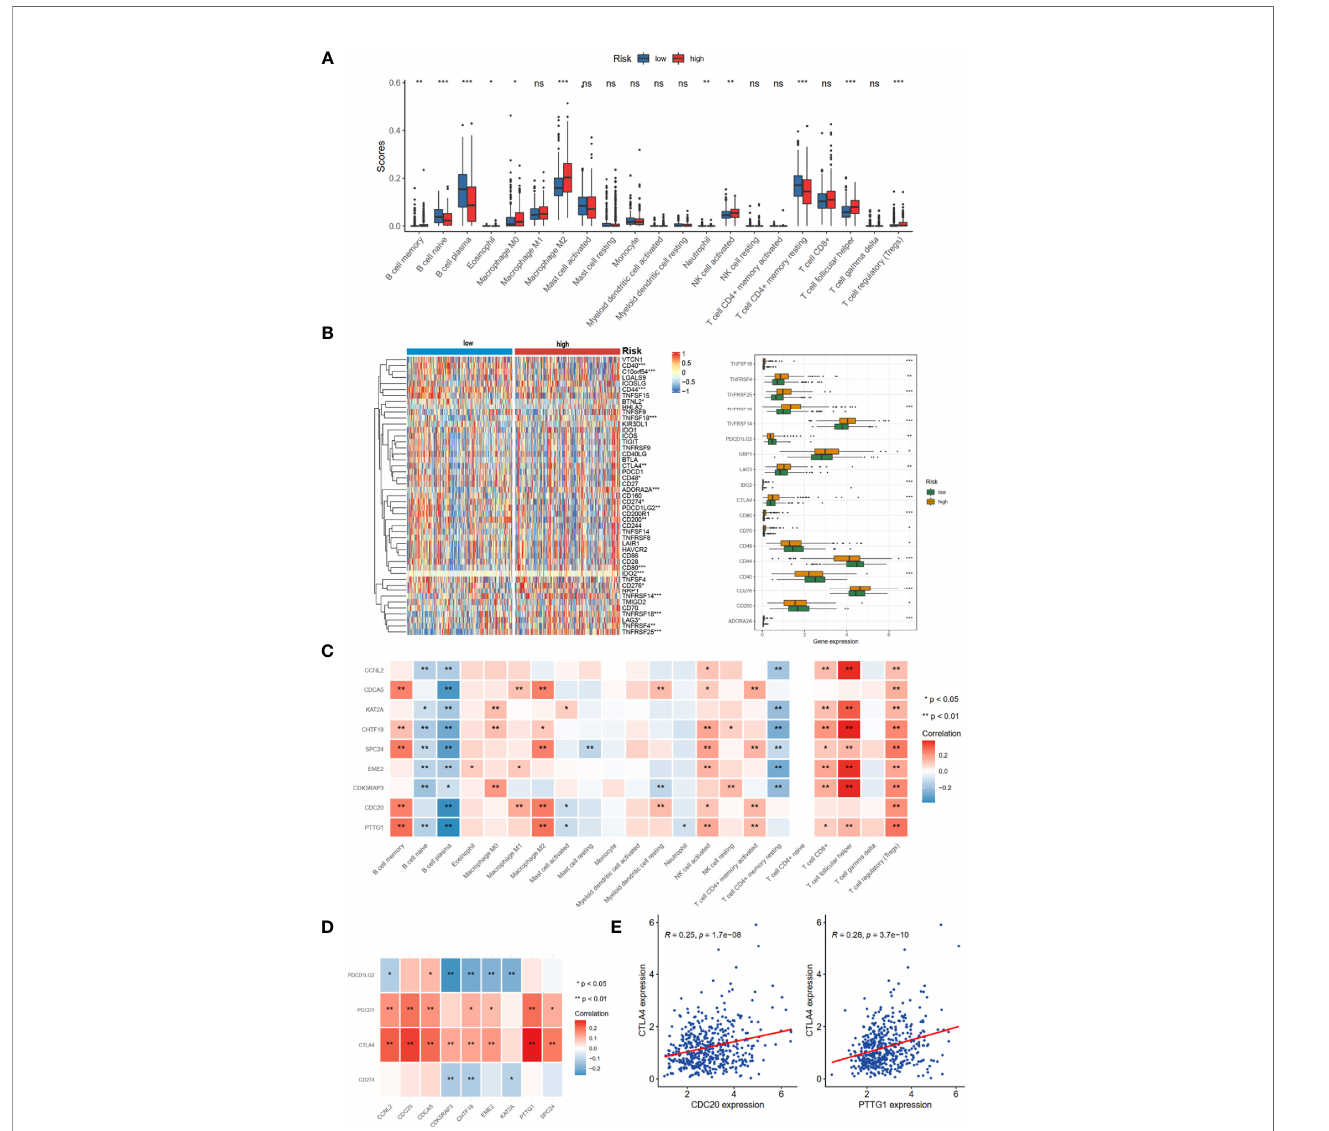
FIGURE 6 | TME immune cell in fi ltration landscapes of different risk groups. (A) Differences of 24 TME in fi ltration cells based on CIBERSORT algorithm. (B) The mRNA expression pro fi les of common immune checkpoint genes. (C) The correlations between 9-risk genes and TME in fi ltration cell type. Red, positive; blue, negative. (D) The correlation between 9-risk genes and immune checkpoint molecules. (E) The correlation between REC, CTLA4, and PDCD1 (PD1). TME, tumor microenvironment. ns, no signi fi cance. * p < 0.05, ** p < 0.01, *** p <